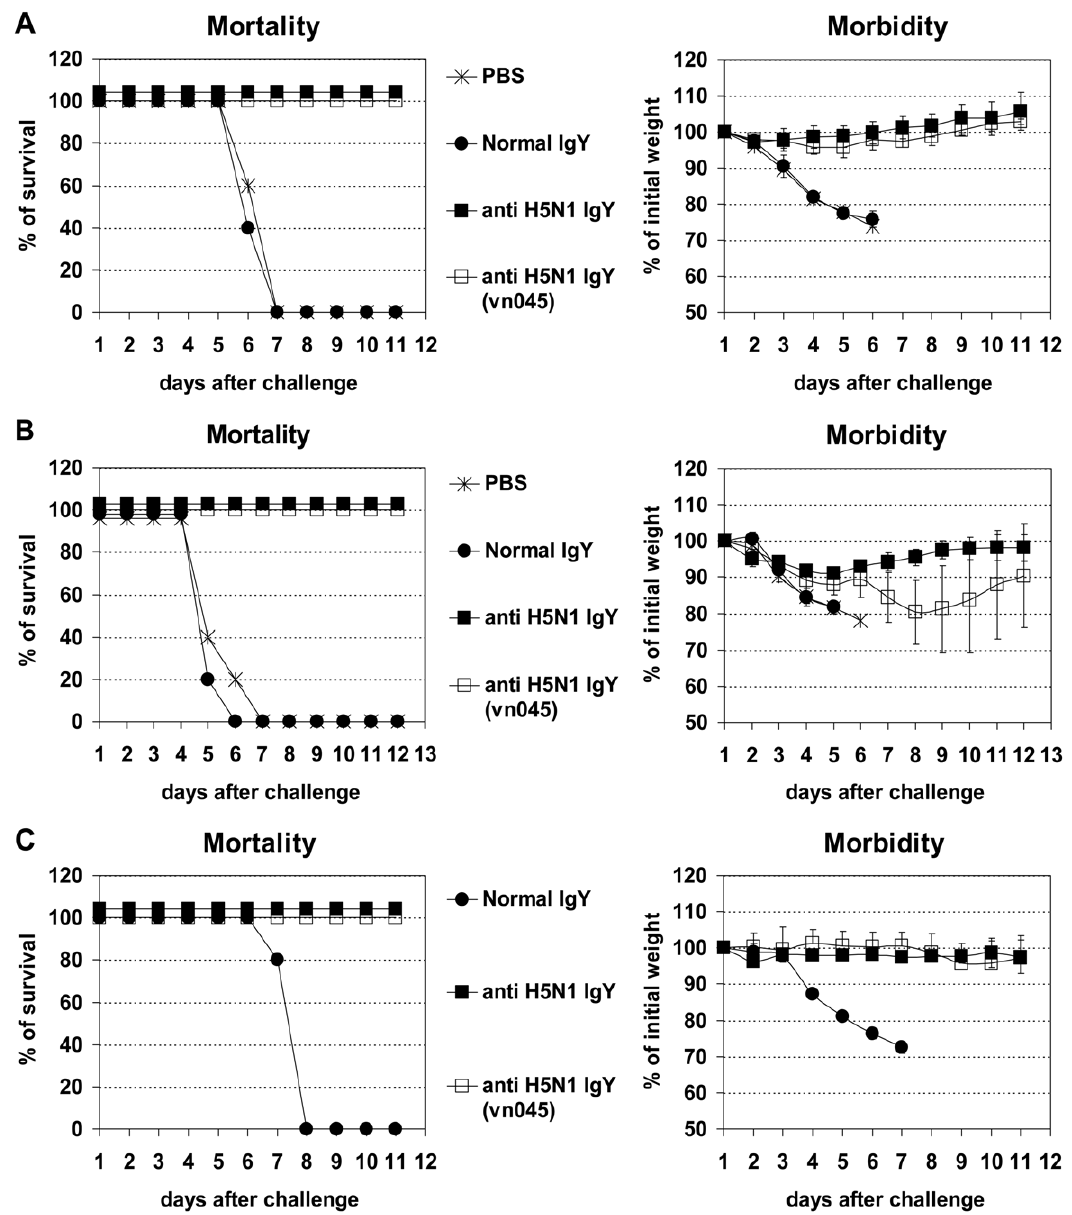
Figure 1. Protection against challenge with A/Aquatic bird/Korea/W81/2005 (H5N2). BALB/c mice were treated with H5N1-specific IgY [anti H5N1 IgY or different batch of anti H5N1 IgY (vn045)] at 6 hours before and 18, 42, and 66 hours after infection with H5N2 virus (Pre- and post- infection treatments, Fig. 1A); at 6, 30, 54, and 78 hours after infection (Post-infection treatments, Fig. 1B); or once at 6 hours before infection (Single pre-infection treatment, Fig. 1C). Five LD 50 of mouse-adapted A/Aquatic bird/Korea/W81/2005 (H5N2) virus and 50 m l of IgY were used for intranasal infection and treatment, respectively. The values are the mean of 5–10 mice in each group.